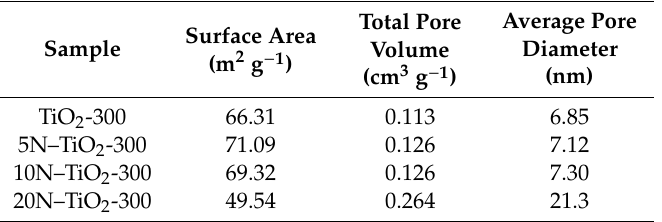
Table 3. Brunauer–Emmett–Teller (BET) surface area, pore volume, and pore diameter of di ff erent mol% N–TiO 2